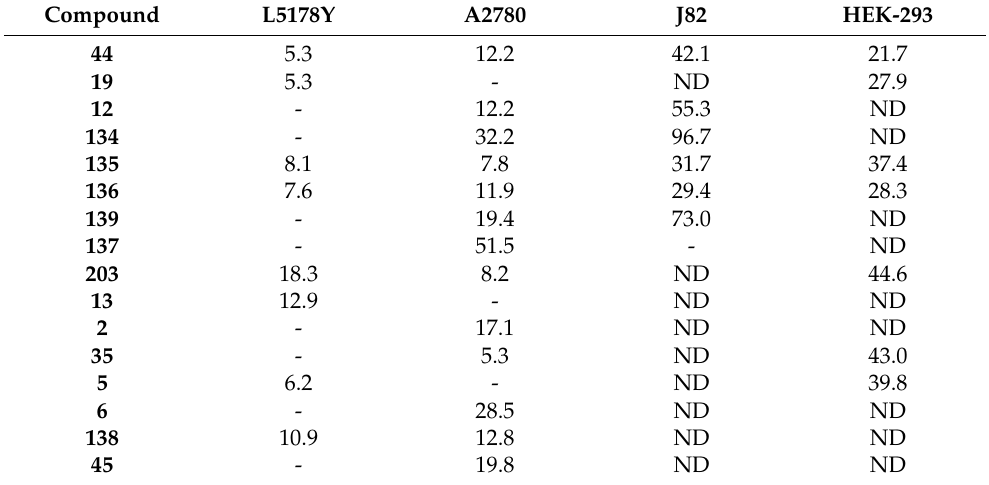
Table 2. The cytotoxicity (IC 50 in µ M) of several compounds towards the L5178Y, A2780, J82 and HEK-293 cell lines. Reproduced with permission [48]. Copyright 2019, American Chemical Society. Compound